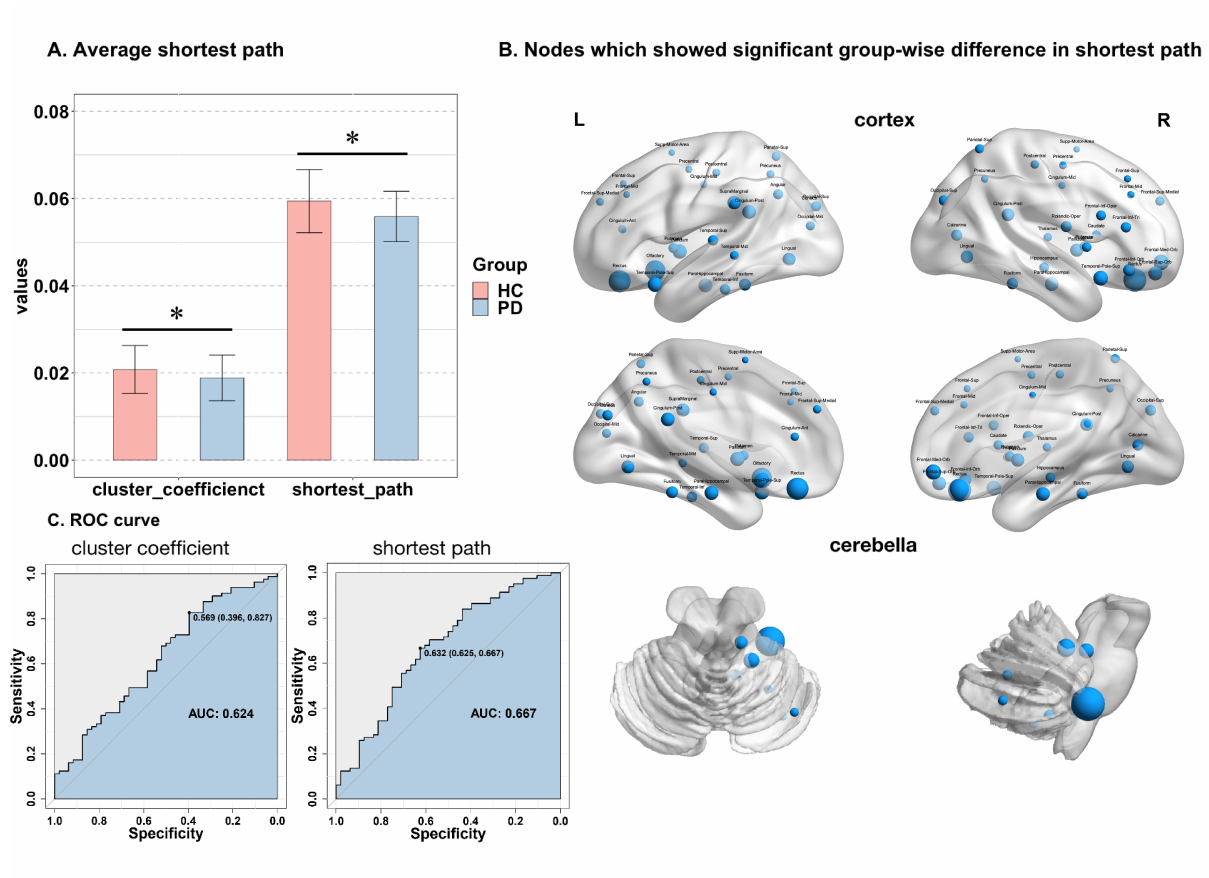
Figure 3. Global cluster coefficient, global average shortest path, and nodal shortest path length. ( A ) * showed significant differences in average cluster coefficient and shortest path between HC and PD groups. ( B ) Nodes, which showed a significant group-wise difference in the shortest path. The size of nodes refers to the magnitude of the nodal shortest path. ( C ) ROC curves for the logistic models of global cluster coefficient and shortest path. The optimal threshold of the cluster coefficient leads to a specificity of 0.396 and a sensitivity of 0.827, while the optimal threshold of the shortest path leads to a specificity of 0.625 and a sensitivity of